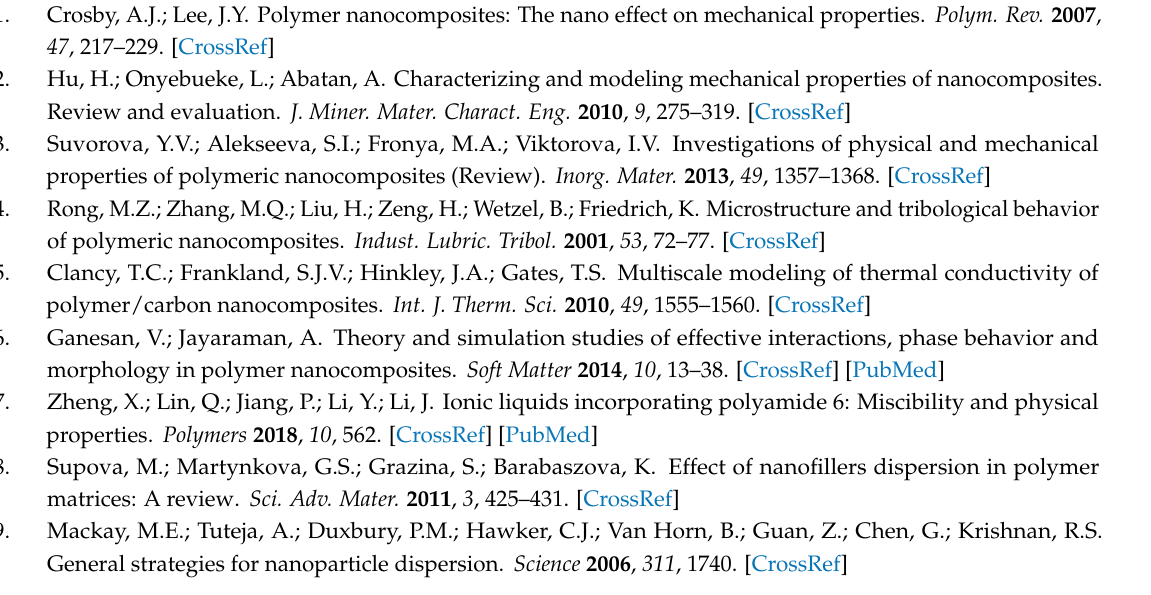
2591/s1, Figure S1: R 2 g versus N , Figure S2: Cumulative radial distribution of NP-NP distances, Figure S3: Additional radial distribution of NP-NP distances, Figure S4: Additional MSDs of NPs and polymers, Figure S5: Additional crosslink and survival probabilities, Figure S6: Test of Equation (10), Figure S7: Analysis of system size effects, Figure S8: Analysis of system size effects, Figure S9: 3D snapshots, Figure S10: Primitive path length L pp , Figure S11: Additional entanglement number density version II profiles, Figure S12: Additional entanglement number density version I and II profiles, Figure S13: Hypothetical number of entanglements around an individual NP, Figure S14: Entanglement networks at φ ≈ 11.6%, Figure S15: Entanglement networks at φ ≈ 28.3%, Figures S16 and S17: MSD of monomers at interphase and bulk